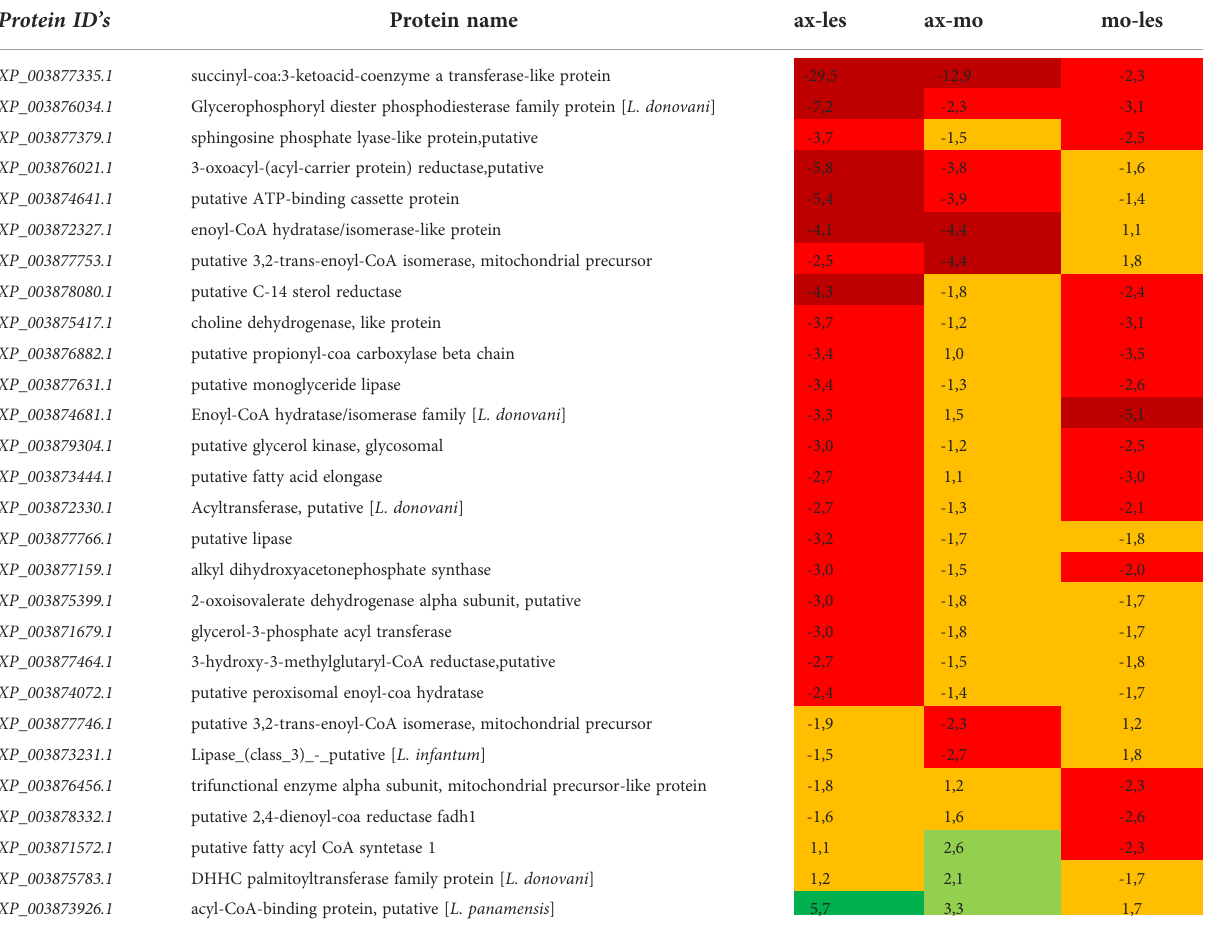
TABLE 3 Proteins involved in lipid metabolism identi fi ed in all 3 comparisons that differ by at least 2-fold (T-test signi fi cant) between individual amastigote types. Lipid metabolism Protein ID ’